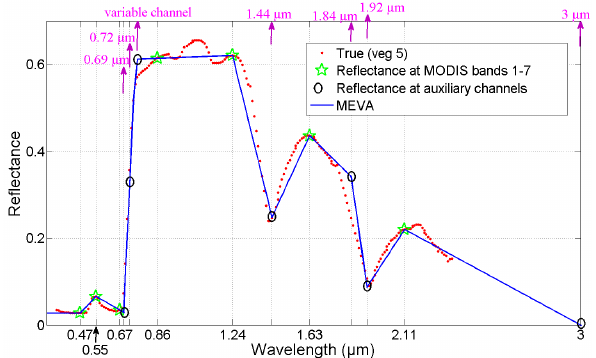
Fig. 7. The procedures for MEVA were applied to the reflectance spectra from the JHU spectral library for dry grass, green grass, conifer, and deciduous. The x-axis represents the wavelength from 0.3 to 2.5µm; the y-axis represents the reflectance; the dotted red curves represent the reflectance spectra from the JHU spectral li- brary; the solid blue lines represent the MEVA